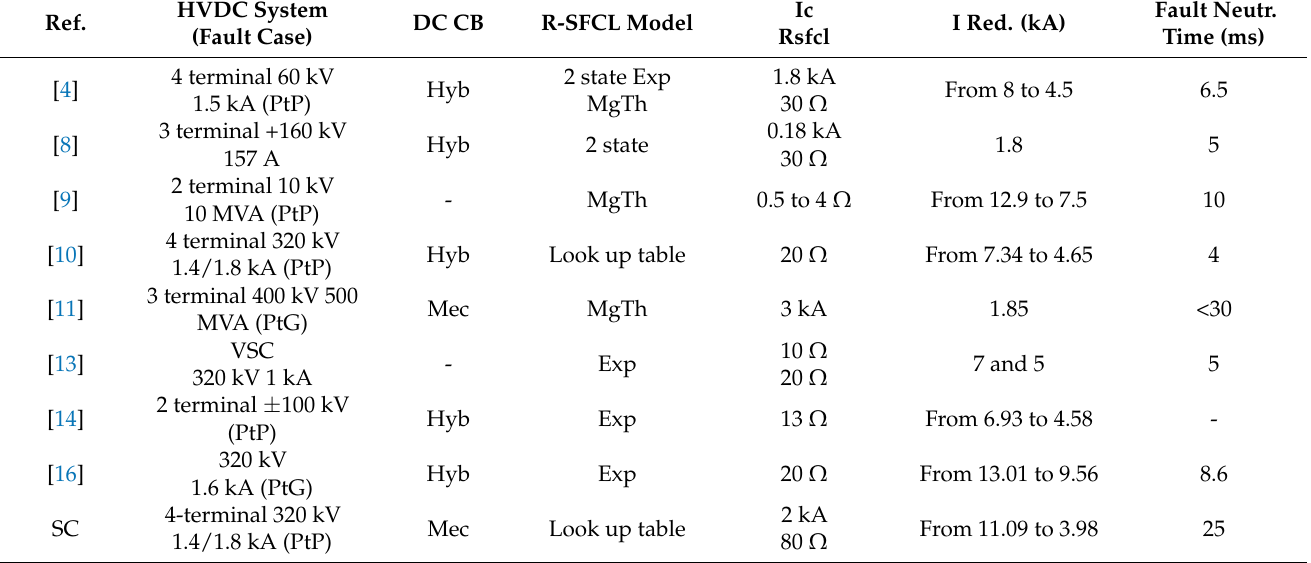
Table 7. Comparison with the existing